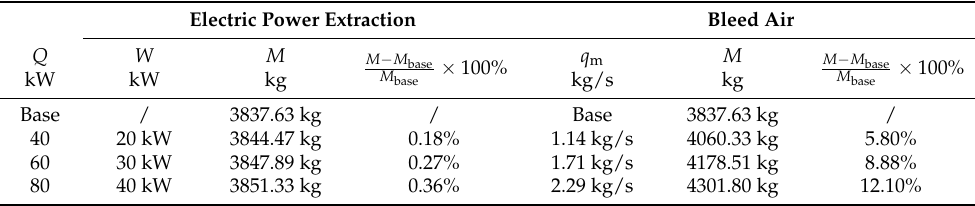
Table 5. The total fuel consumption. Electric Power